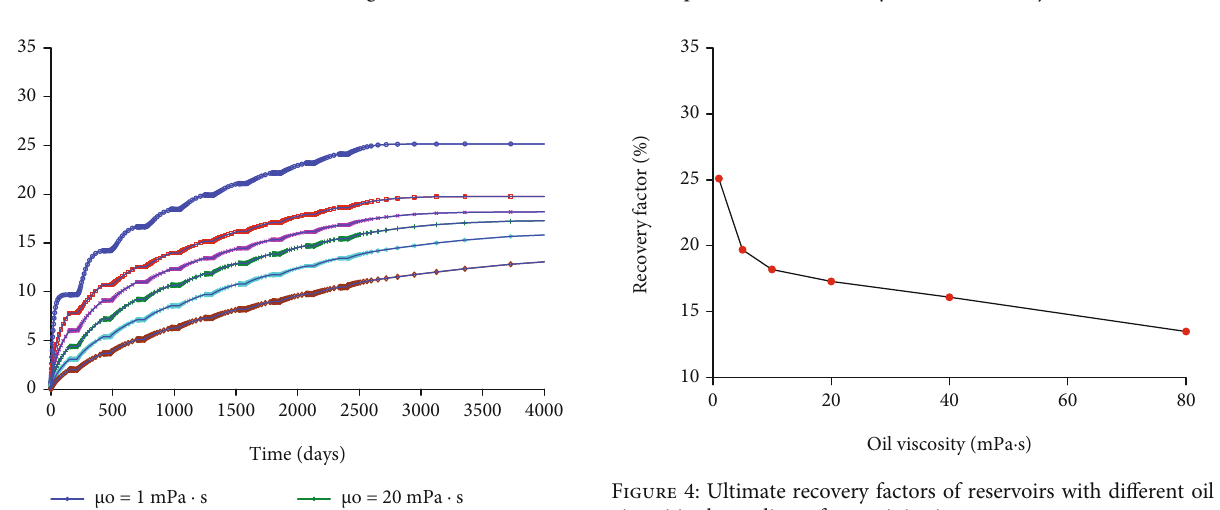
Figure 2: Production curves of oil-wet tight reservoirs with conventional depletion and the new cyclic surfactant injection method.